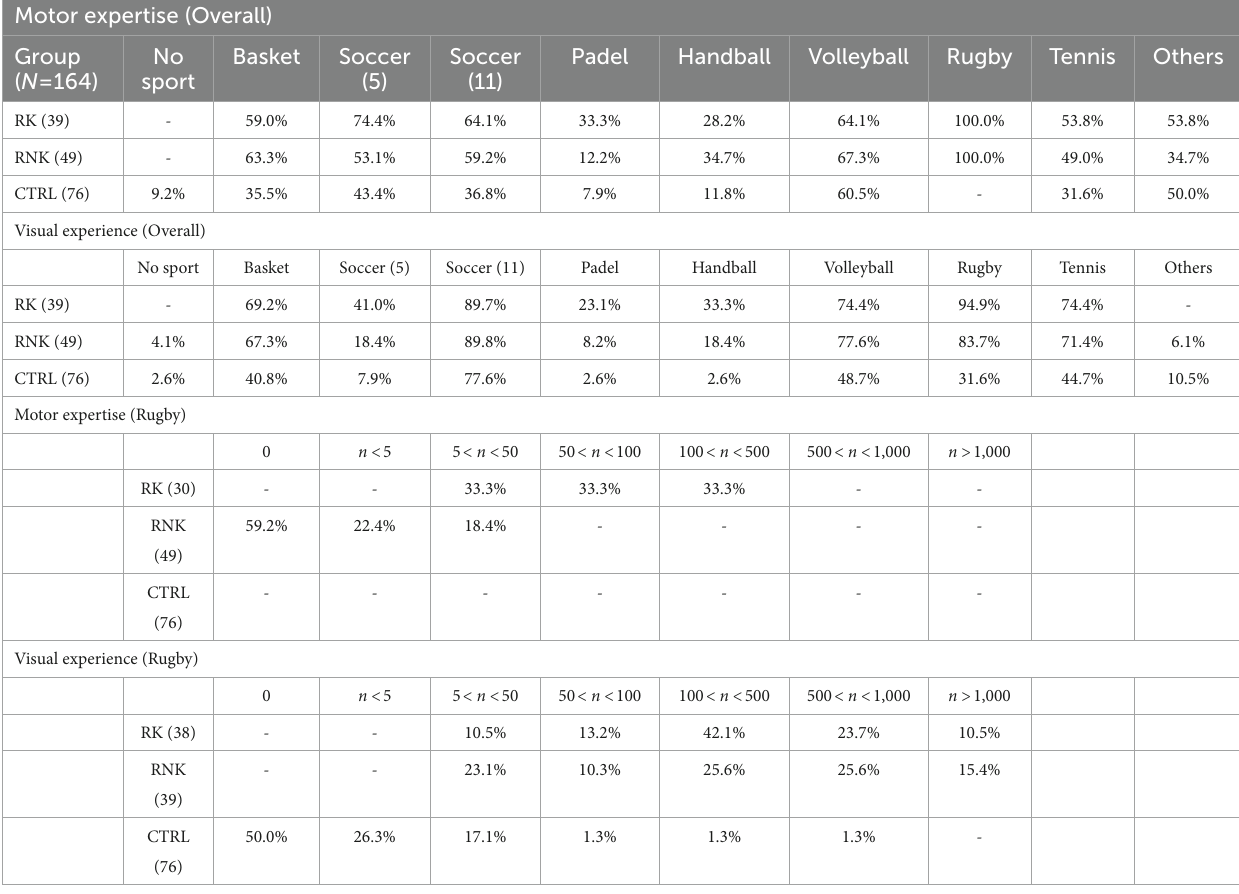
TABLE 1 Descriptive characteristics of the motor expertise and visual experience of the total sample. Motor expertise